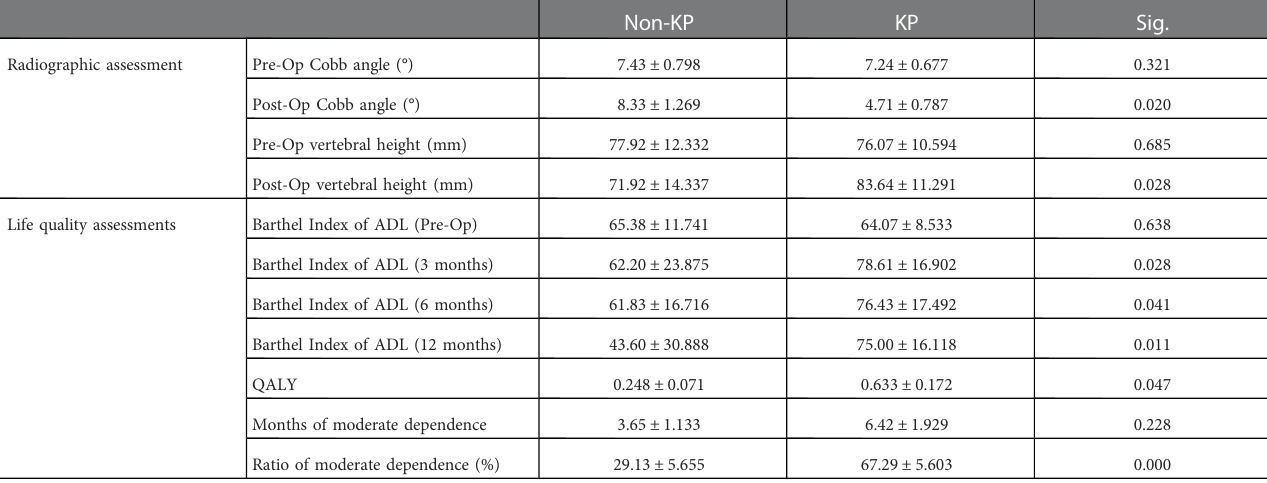
TABLE 5 Detailed information of radiographic assessment and life quality assessments. Non-KP KP